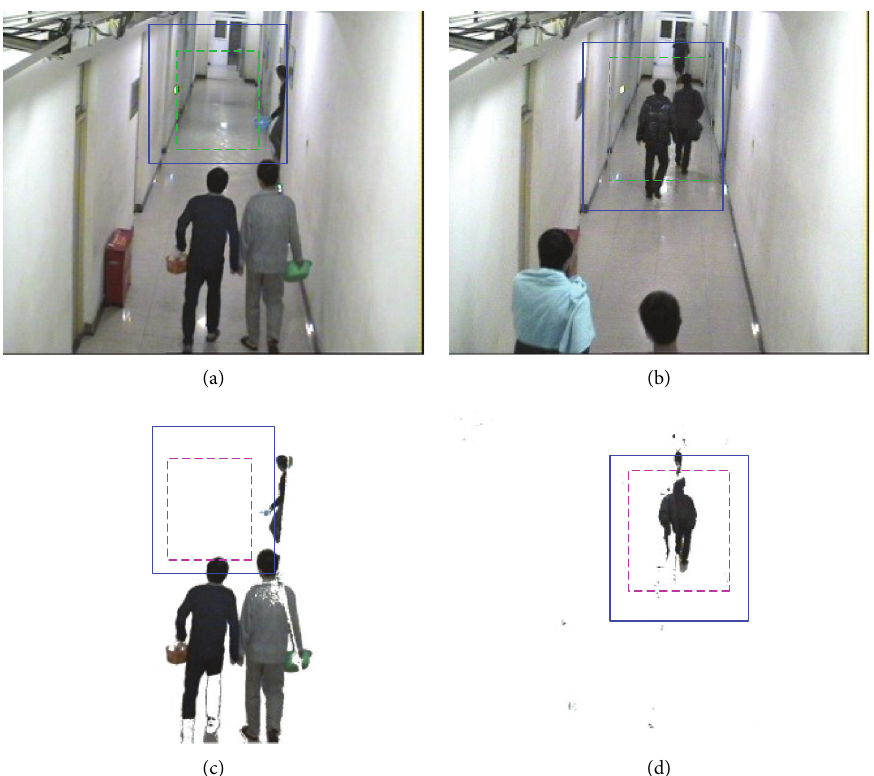
Figure 8: The experiment results of complex background scene: (a) first frame image; (b) 50th frame image; (c) binarized image; (d) background differential binary